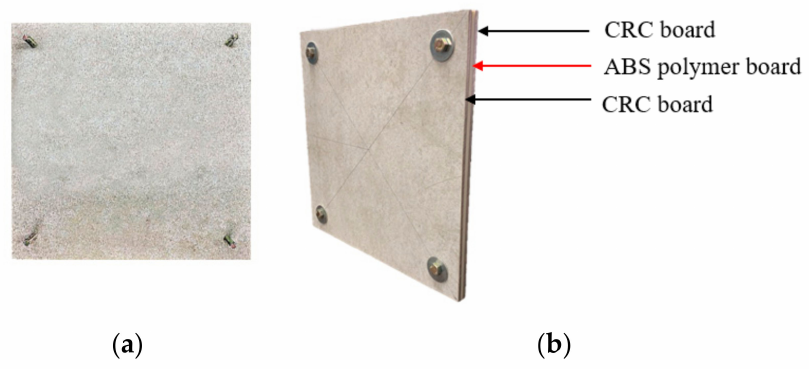
Figure 2. Details of the cellulose-fiber-reinforced cement board: ( a ) CRC board; ( b ) 3D printed composite curtain